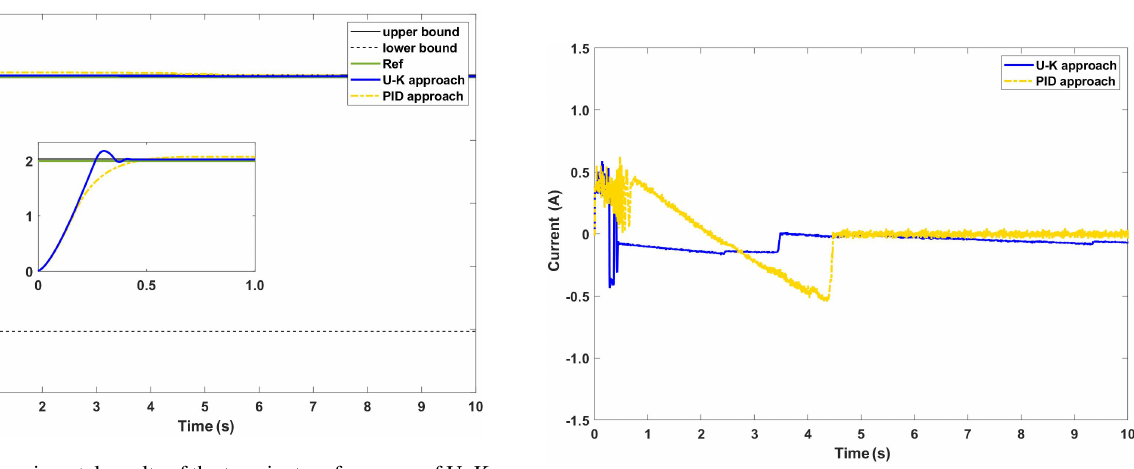
Figure 9. The control input of the transient performance of U–K and